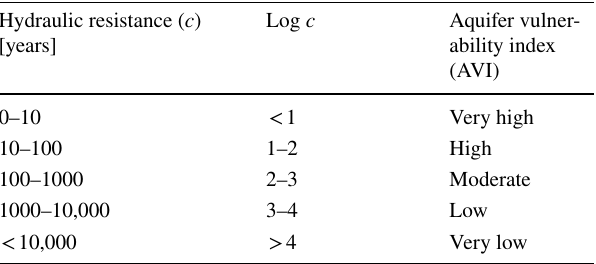
Table 8 Relationship of aquifer vulnerability index to hydraulic resistance (Van Stempvoort et al. 1993)